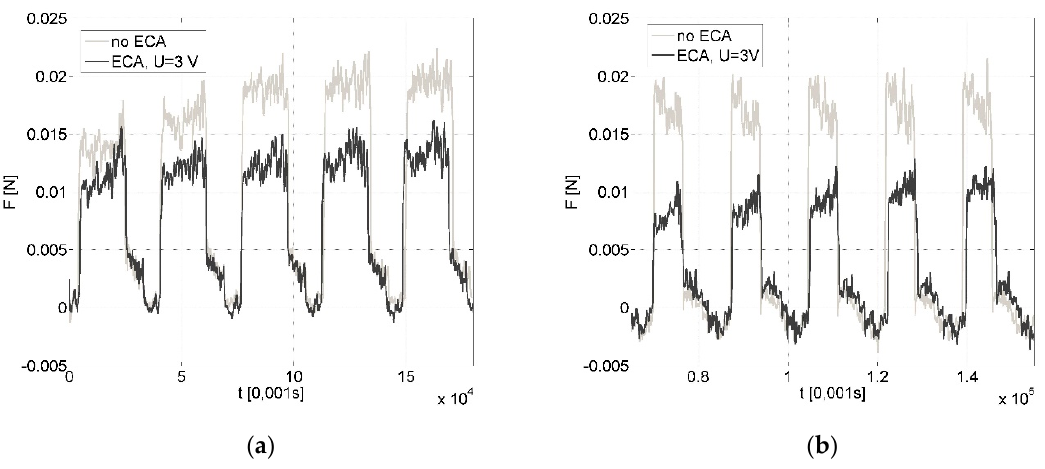
Figure 5. Relation of force sensor load during cutting with the following parameters: feed rate f = 3 µ m/rev, cutting speed: V c = 40 m/min ( a ) and V c = 120 m/min ( b ), ECA in variant B .